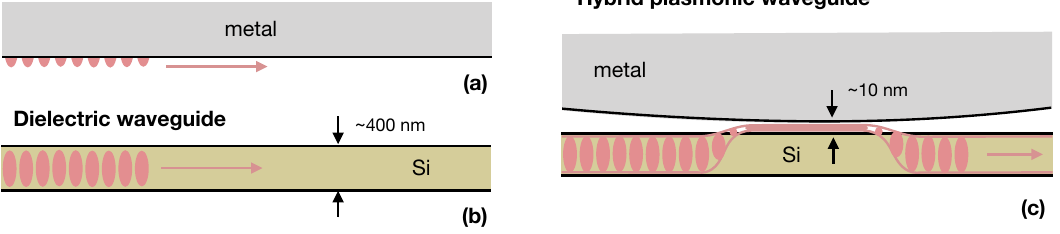
Figure 2. Combining a plasmonic waveguide ( a ), represented by a metallic surface, with a dielectric waveguide ( b ) one can form a hybrid plasmonic waveguide ( c ). A hybrid mode evolution is accompanied by a periodic energy transfer between the dielectric waveguide and the gap. Choosing the right length and distance one can use this effect to perform a smooth conversion of the waveguide mode into plasmon and back. A similar mechanism in successfully used in various models of plasmonic electro–optical